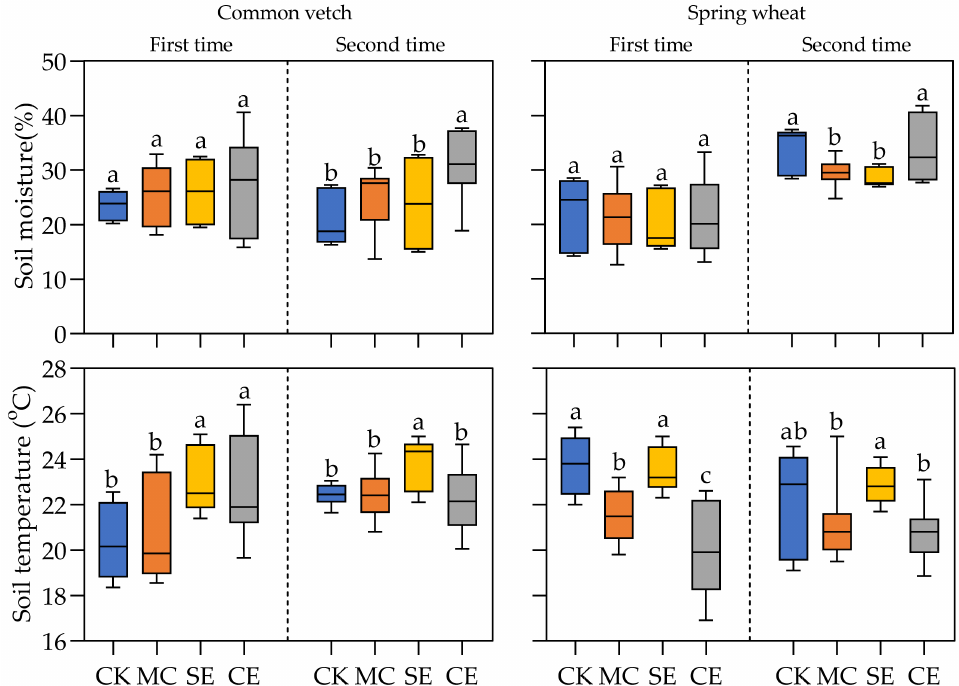
Figure 3. Soil moisture (SM) and soil temperature (ST) of the two forage crops. The significant differences were labeled with letters using Duncan’s notation, from largest to smallest: a, b, c. If there is no significant difference between two values, the same or overlapping letters are used for both